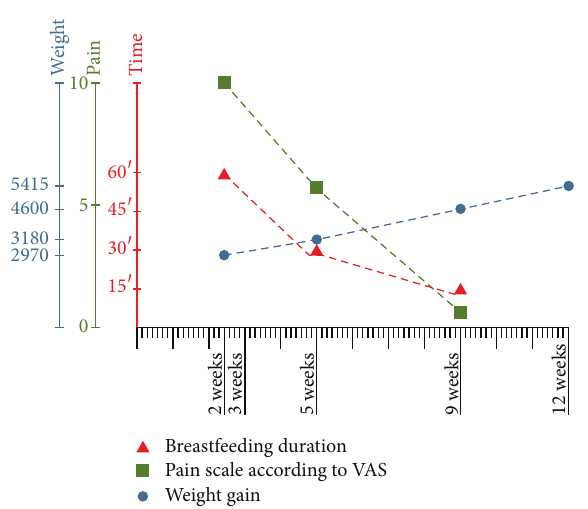
Figure3:GraphoftheprogressofthepatientfollowingtheCELERE